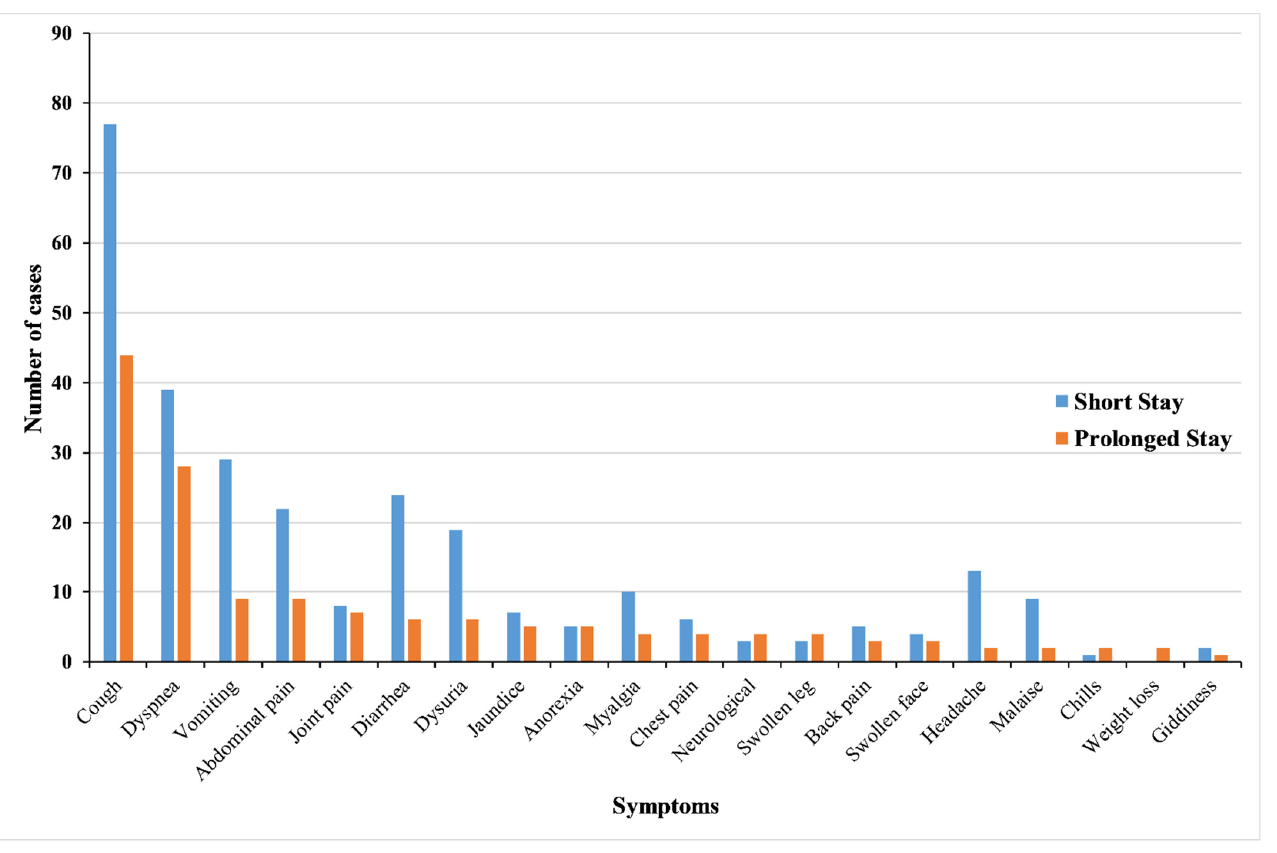
Figure 3. Symptoms at presentation stratified according to the length of hospital stay among patients admitted with fever in Samtse Hospital, Bhutan, 2020.